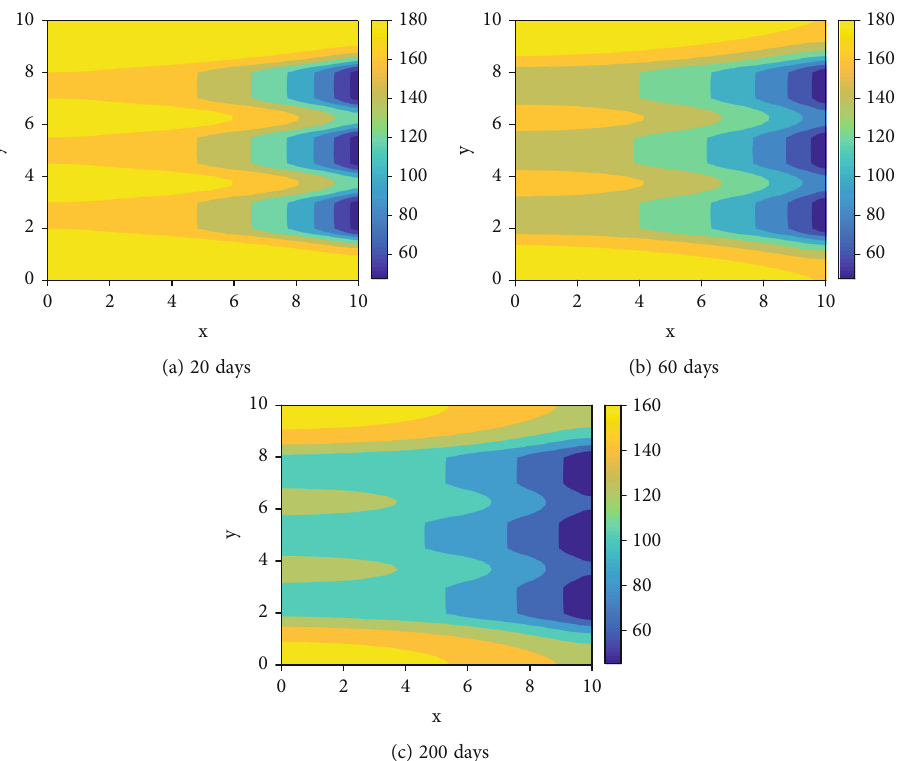
= 40 mol/m 3 at di ff erent times. b